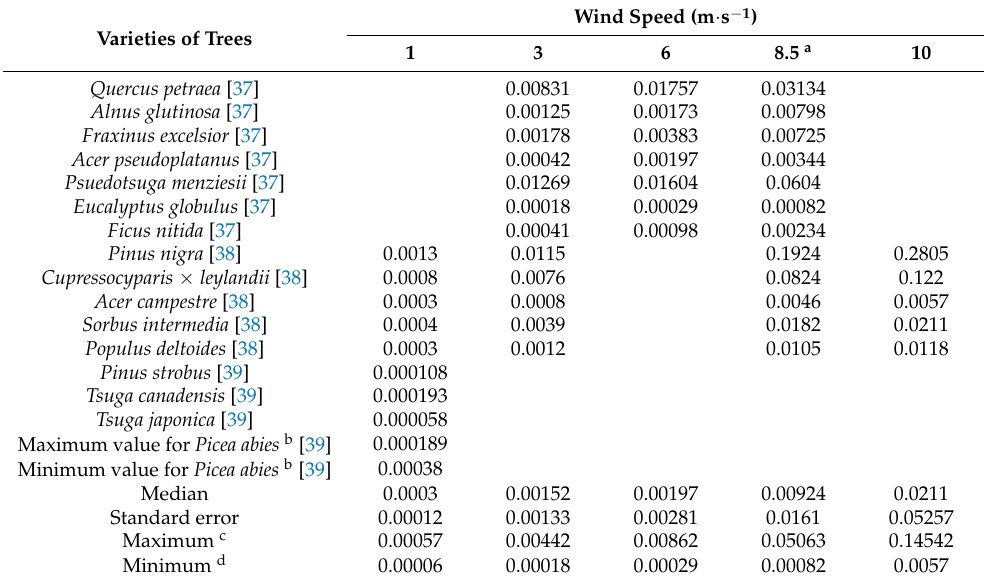
Table 1. Deposition velocity (m · s − 1 ) of PM 2.5 by wind speed per unit leaf area (taken from [37–39]). Varieties of